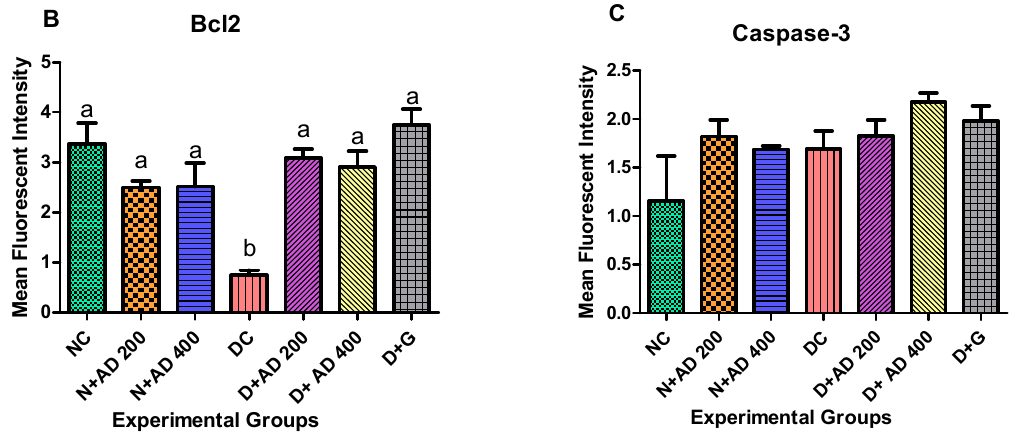
Figure 7. ( A ) Fluorescence micrographs showing the effect of AD intervention on apoptotic markers in the kidney tissues of normal and diabetic rats. Quantification of the level of expression of ( B ) caspase 3 and ( C ) Bcl2 in the kidney tissues.